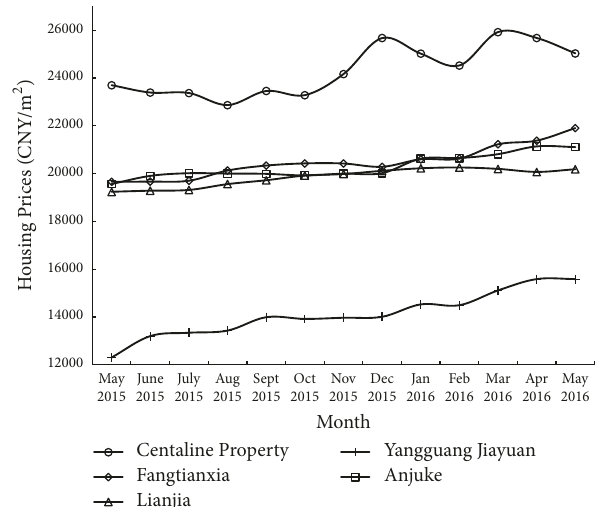
Figure 3: Second-hand residential housing prices in Guangzhou (May 2015-May